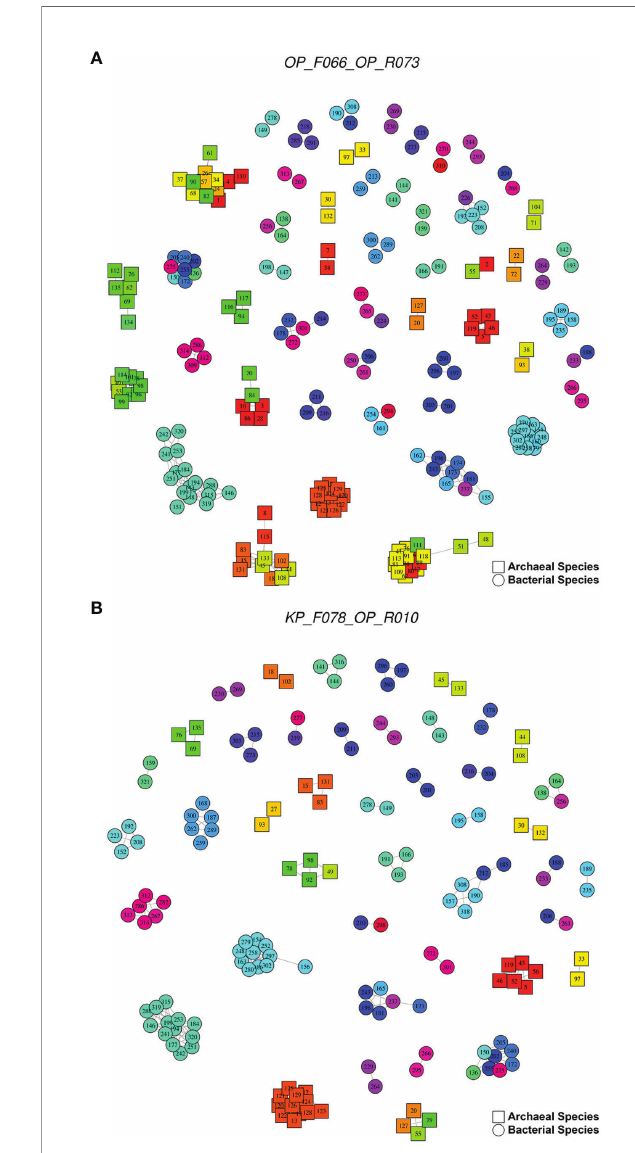
FIGURE 6 | Networks showing the potential OTUs with a ≥ 97% similarity threshold obtained with the primer pairs. (A) OP_F066-KP_R040 for bacteria (120 species with ASI97, 277 ASI97). (B) OP_F066-KP_R013 for archaea (89 species with ASI97, 240 ASI97). In the graphs, each node represents an oral species, the color indicates the genus and the number refers to the species identi fi er, whose assigned species are detailed in the Supplementary Tables 1 , 2 . Each edge represents the presence of a ≥ 97% similarity between different species. resulting in clusters of possible OTUs. The graphs were made using the igraph package (version 1.2.6) (Csardi and Nepusz, 2006).